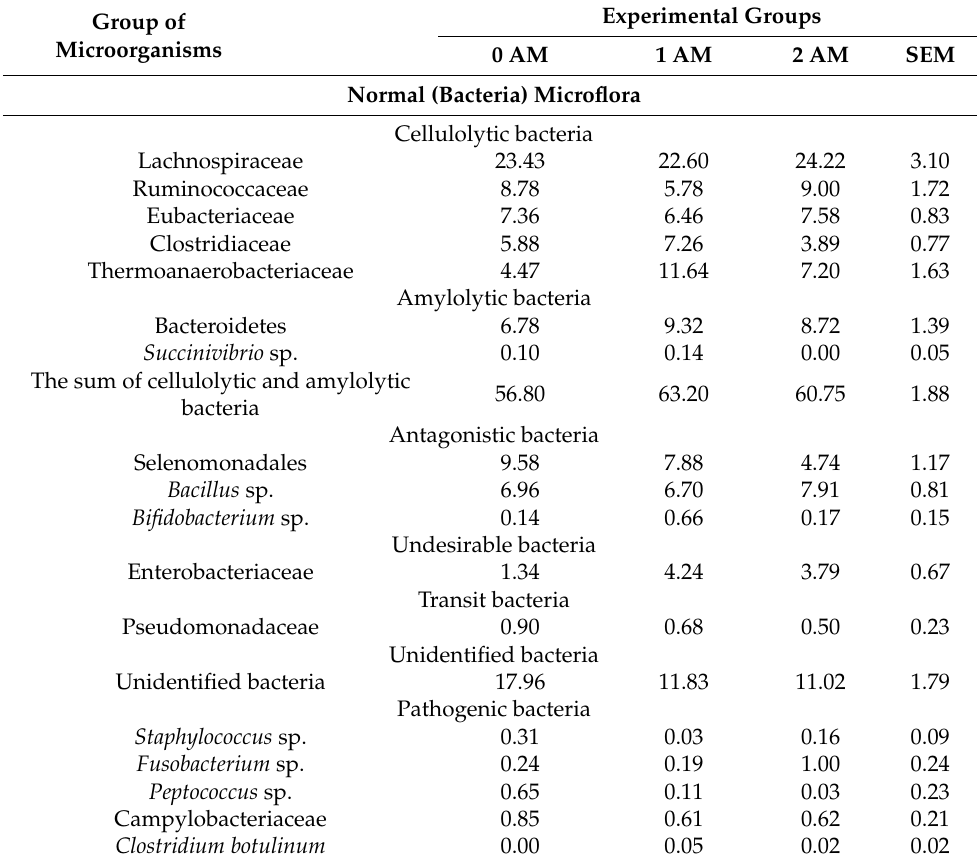
Table 7. Percentages of rumen microbiota of Ayrshire dairy cows at the end of lactation period (DIM = 305 ds).